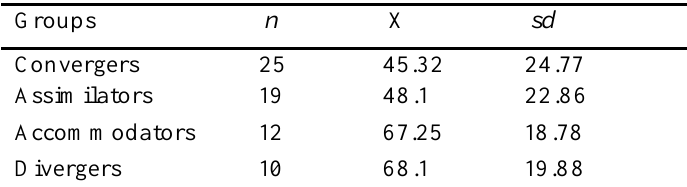
Average Scores of Four Learning Style